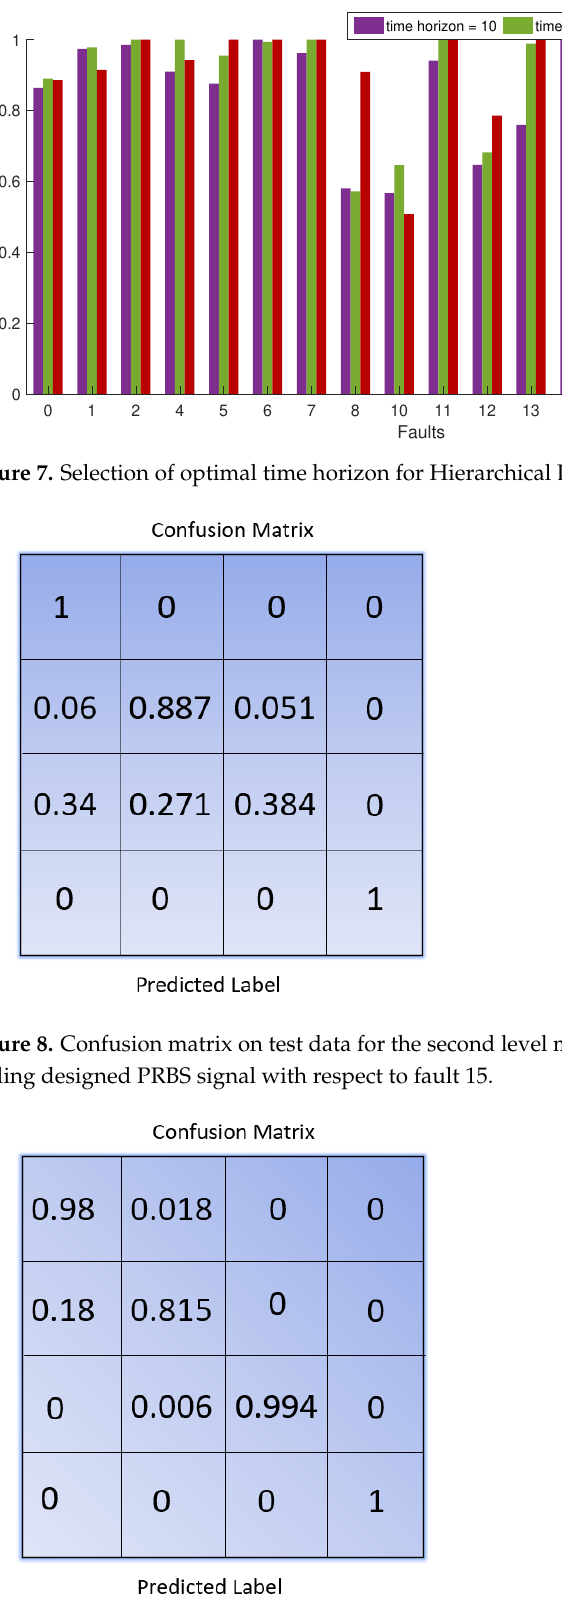
Figure 9. Confusion matrix on test data for the second level model of the hierarchical structure: after adding designed PRBS signal with respect to fault 9 and fault